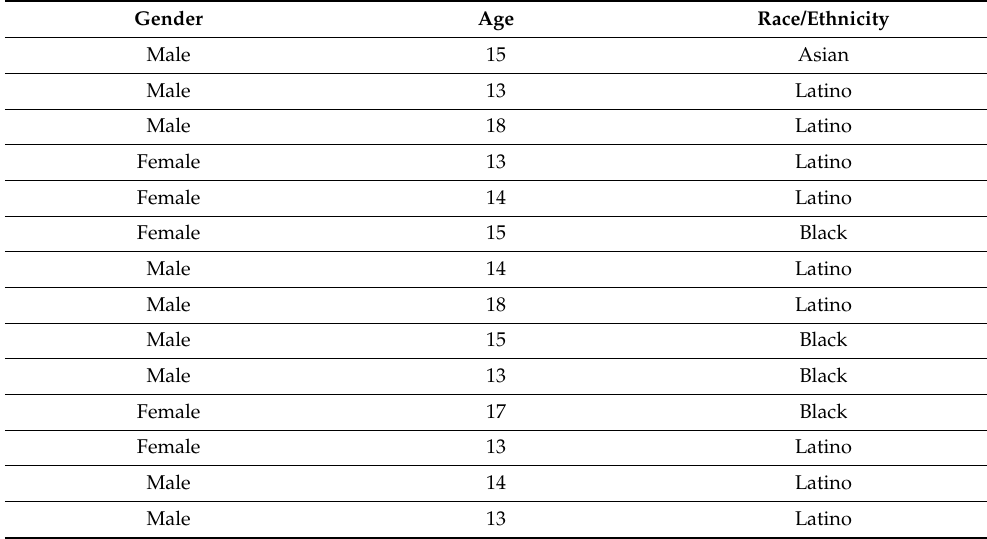
Table 2. Characteristics of consented